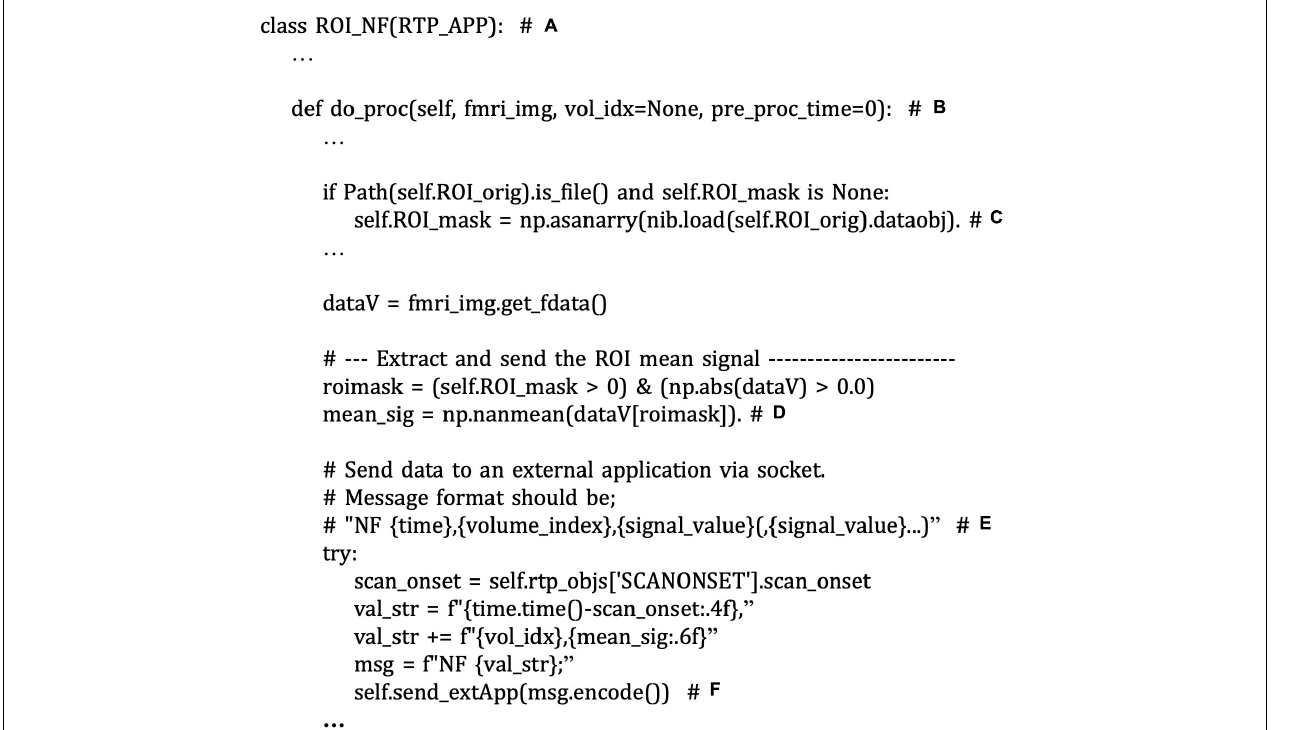
FIGURE 10 | A snippet of an example script of customized neurofeedback signal extraction and sending the signal to an external application in the “ example/ROI-NF/roi_nf.py ” file. The comments with bold alphabet indicate a part of the script explained in the main text. ROI_NF class is defined by inheriting RTP_APP class (A) . Neurofeedback signal extraction is performed in the “ do_proc ” method (B) . The example script calculates the mean value within the ROI mask (D) . The ROI mask file is defined in the “ ROI_orig ” property (C) . The signal can be sent to an external application in real-time using the “ send_extApp ” method (F) by putting it in a specific format string (E)